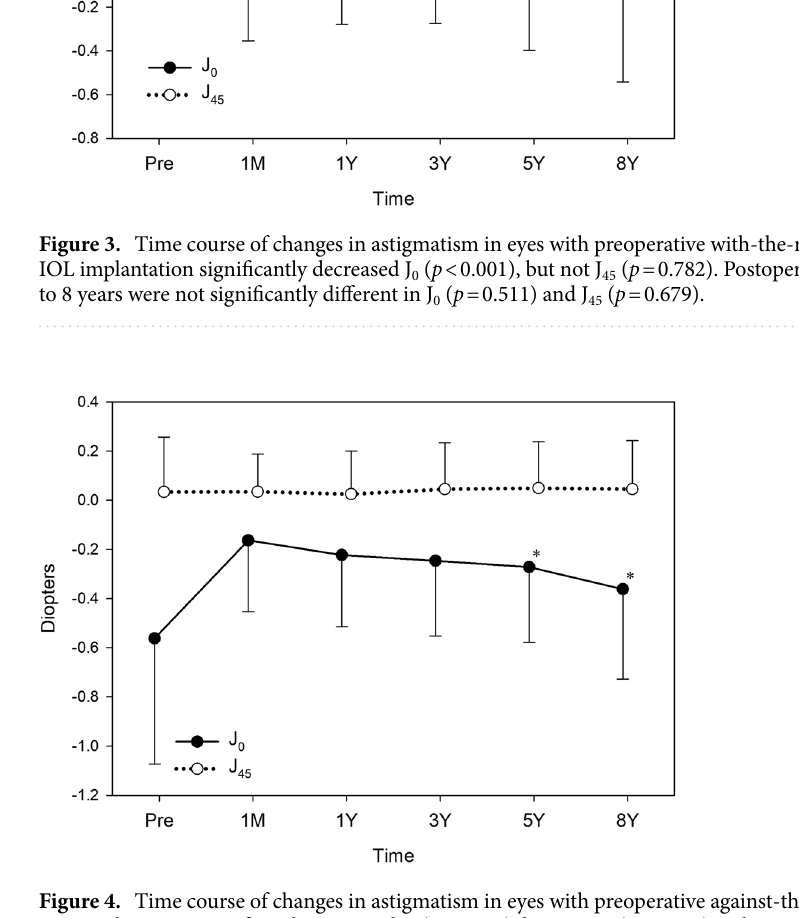
Figure 4. Time course of changes in astigmatism in eyes with preoperative against-the-rule astigmatism. Toric IOL implantation significantly increased J 0 ( p < 0.001), but not J 45 ( p = 0.825). When postoperative values were compared, J 0 showed significant changes after surgery ( p < 0.001), and J 0 values at 5 years (* p < 0.001) and 8 years (* p < 0.001) were significantly smaller than that at 1 month postoperatively. The mean J 45 remained stable from 1 month to 8 years after surgery ( p =